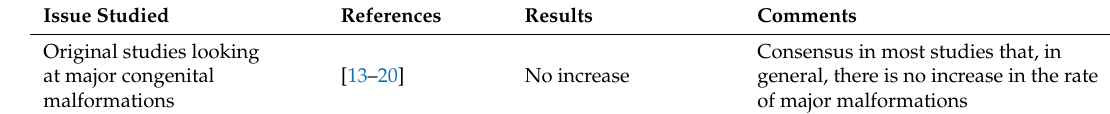
Table 1. Summary of SRI e ff ects in